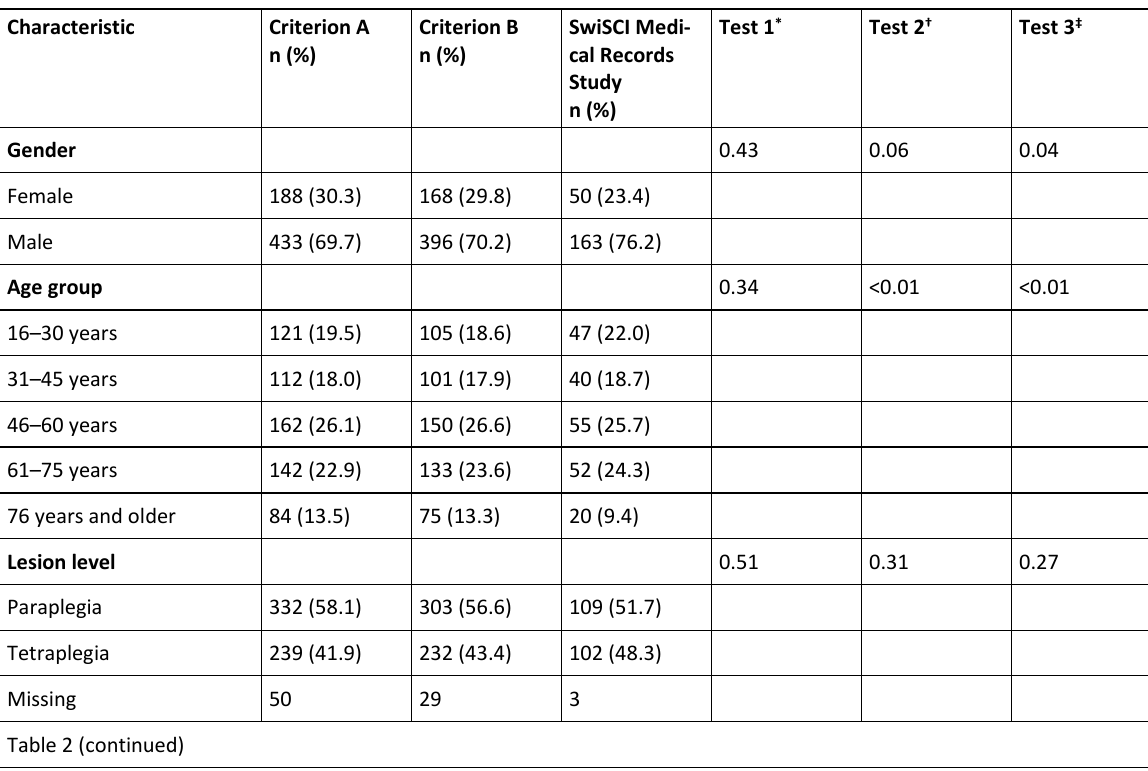
Table 2: Characteristics of the SFSO data and SwiSCI data.